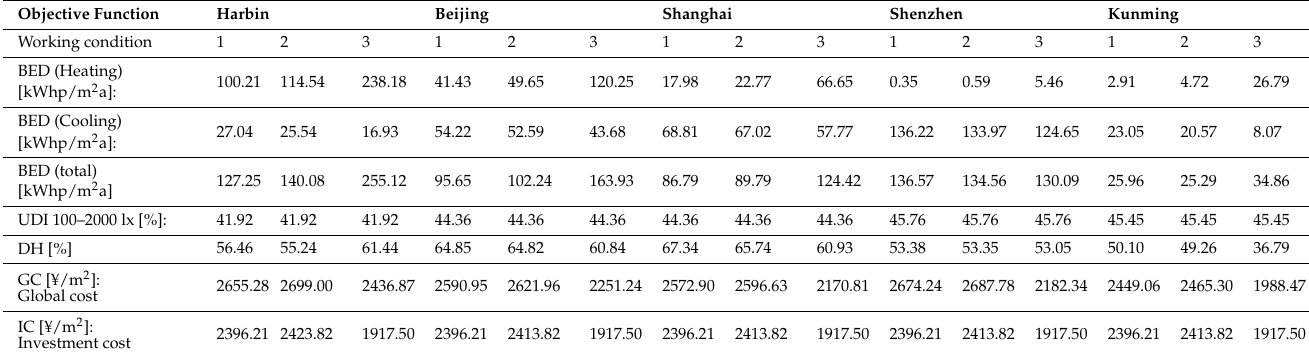
Table 15. Average performance indicators for building type 2 in each typical urban climatic condition. Objective